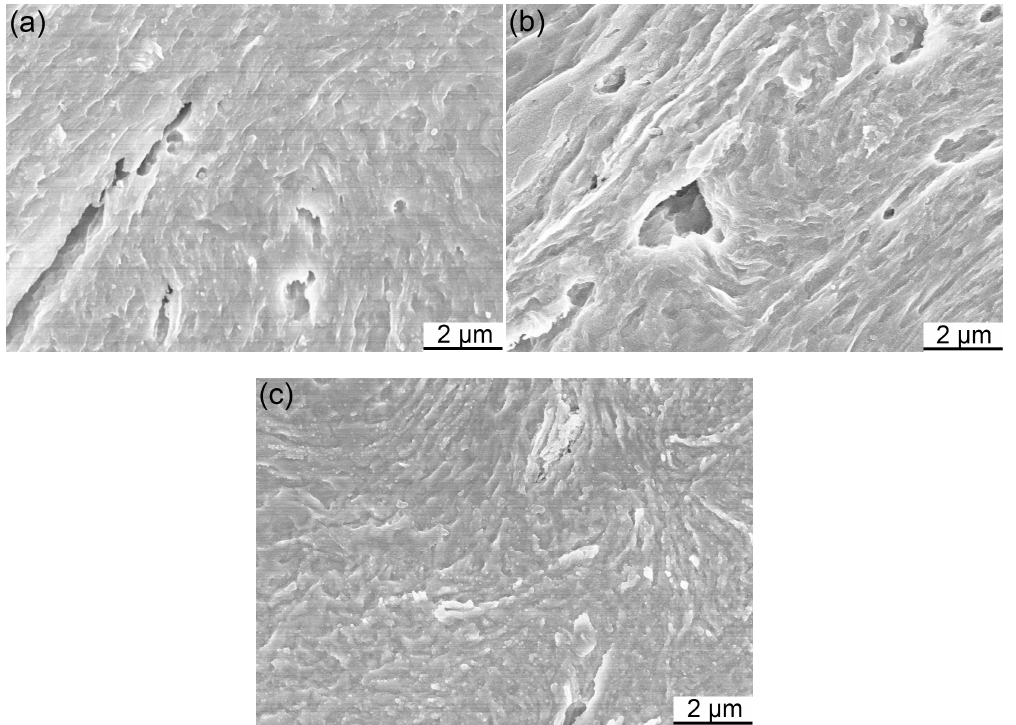
Figure 4. SEM images of polished and etched powders: ( a ) MP; ( b ) MX; ( c ) ODS.